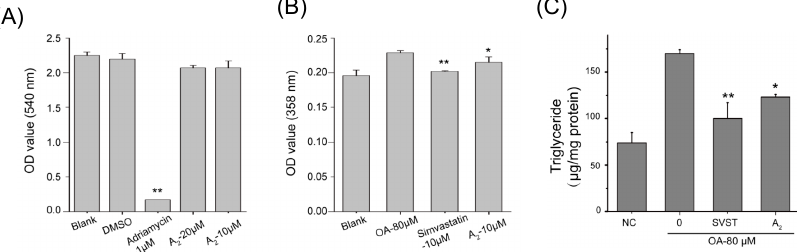
Figure 2. ( A ) The effect of oleiferasaponin A 2 on HepG2 cells proliferation; ( B ) the lipid lowering activity of oleiferasaponin A 2 under oleic acid treatment; and ( C ) the content of triglyceride